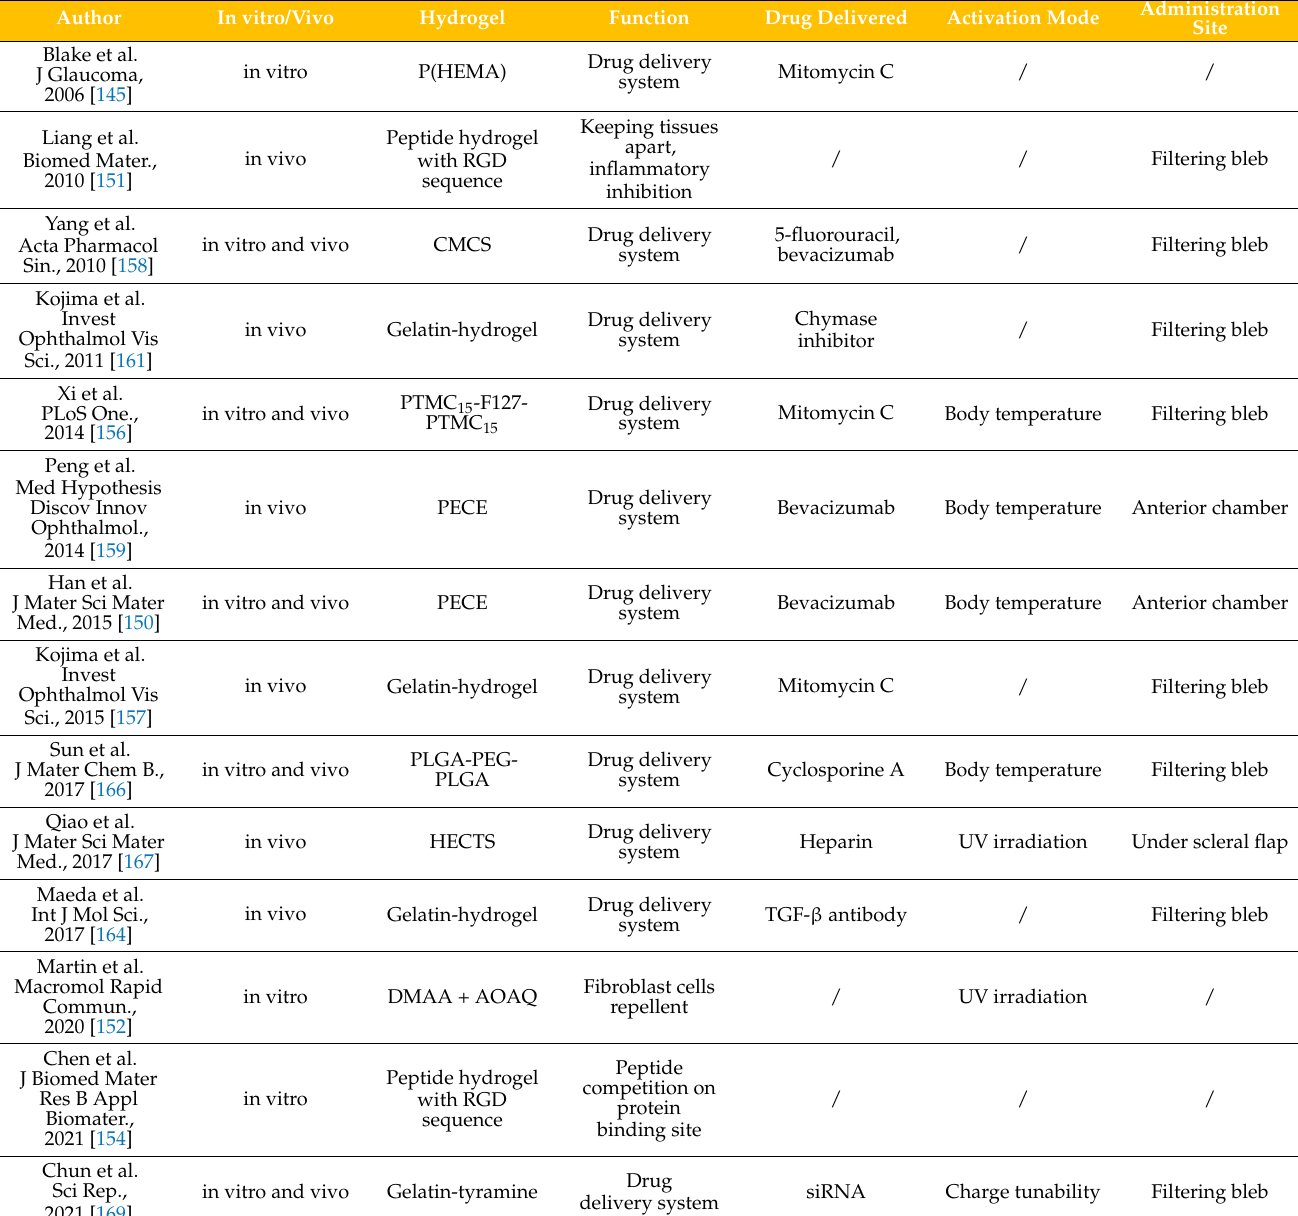
Table 3. Studies on anti-scarring hydrogels in glaucoma filtration